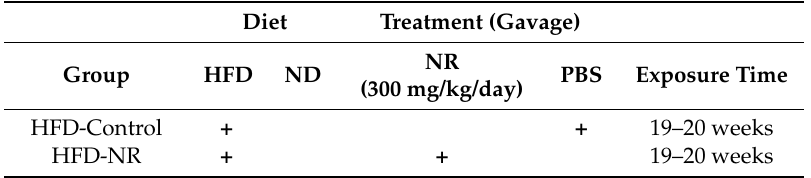
Table 2. Details of NR